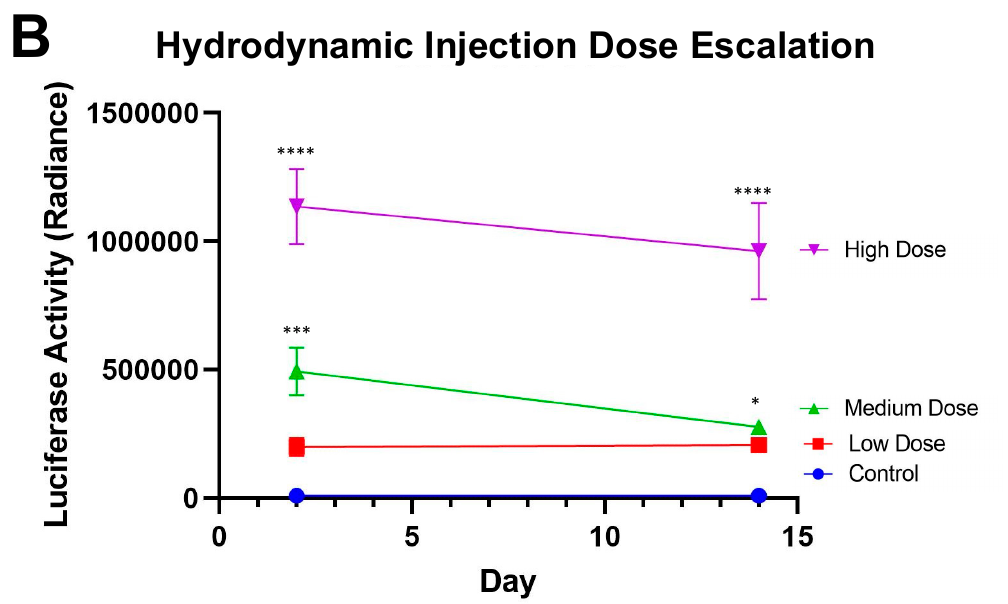
Figure 7. Hydrodynamic dose variation injections. ( A ) Mice were hydrodynamically injected at varying doses of 7.5 µ g, 25 µ g, and 83.3 µ g of plasmid. Day 2 mouse images are shown. ( B ) Radiance levels emitting from the mouse livers were measured and compared. Each day was analyzed by one-way ANOVA and Tukey’s multiple comparison. High and medium doses were significant compared to the control on both days while low dose was not significant compared to the control on either day via one-way ANOVA with multiple comparison. Via one-way ANOVA, high, medium, and low doses were significant compared to each other on Day 2. On Day 14 and by one-way ANOVA with Tukey’s multiple comparisons high dose was significant compared to all other groups. Medium dose was only significant compared to the control dose on Day 14. All other comparisons on Day 14 were not significant by one-way ANOVA with Tukey’s multiple comparisons (n = 3) (* < 0.05, *** < 0.0005, **** < 0.0001).